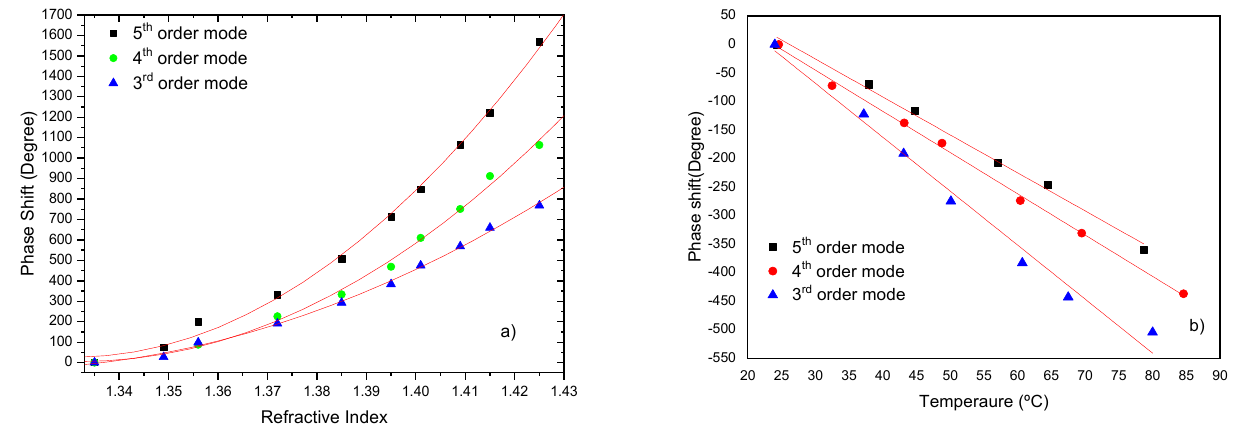
Figure 15. Interferometric phase changes a 140 mm sensing length and excitation of the 3rd, 4th and 5th cladding modes: ( a ) due to refractive index variations; ( b ) as function of liquid temperature.